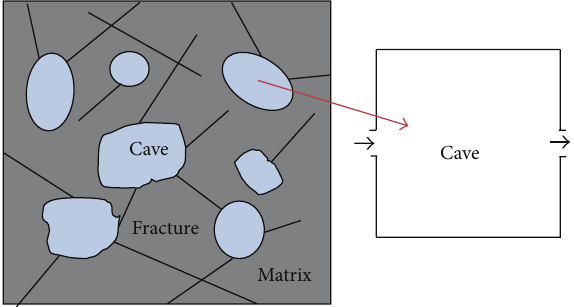
Figure 1: Discrete fracture-cave network model and simplified cave